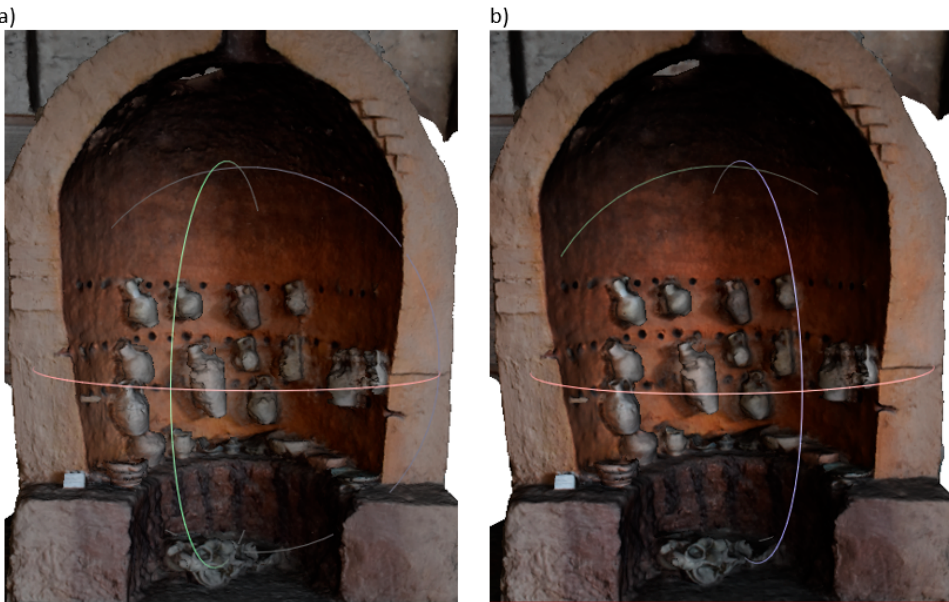
Figure 15. Three-dimensional model of the furnace obtained by the SfM method: ( a ) original version, ( b ) after smoothing the surface.